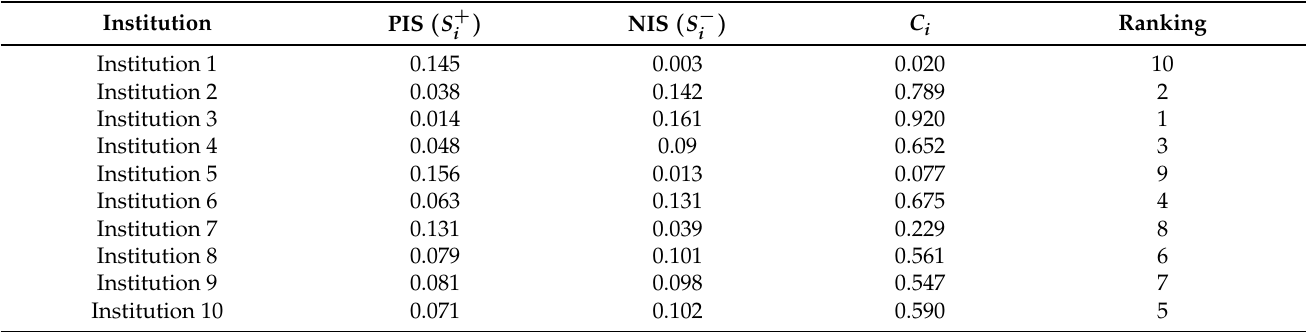
; C i on average and ; S − i i